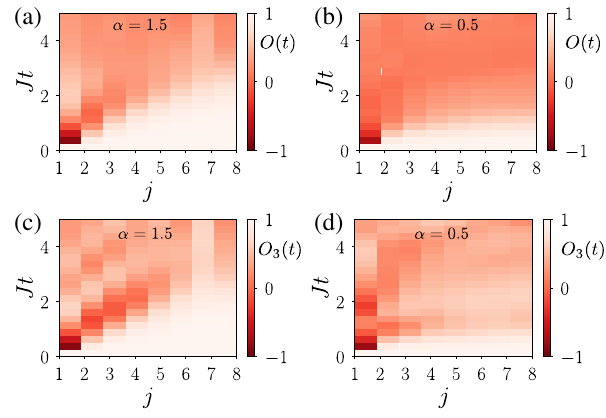
FIG. 6. Scrambling with long-range interactions. (a,b) OTOC O ð t Þ for N ¼ 8 , and two values of α ¼ 1 . 5 , 0.5. (c,d) Same as panels (a) and (b) for the modified OTOC O 3 ð t Þ , which also distinguishes the two regimes of scrambling.